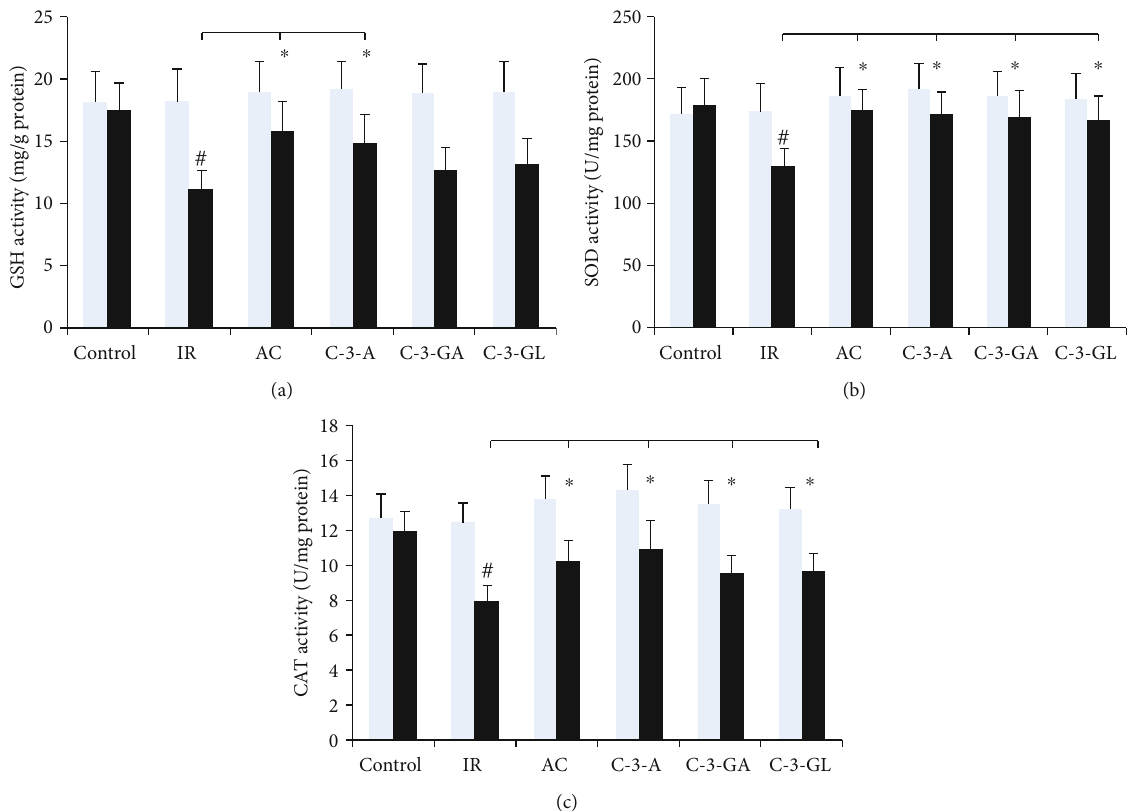
Figure 6: Antioxidant parameter levels in the kidney of the renal IR injury and anthocyanin treatment. The data are the means ± SD . n = 13 per group. GSH: glutathione; SOD: superoxide dismutase; CAT: catalase; IR: ischemic reperfusion; AC: anthocyanins; C-3-A: cyanidin-3- arabinoside; C-3-G: cyanidin-3-glucodise; C-3-GA: cyanidin-3-galactoside. # P < 0 : 01 vs. control within group; ∗ P < 0 : 05 vs. respective IR group.